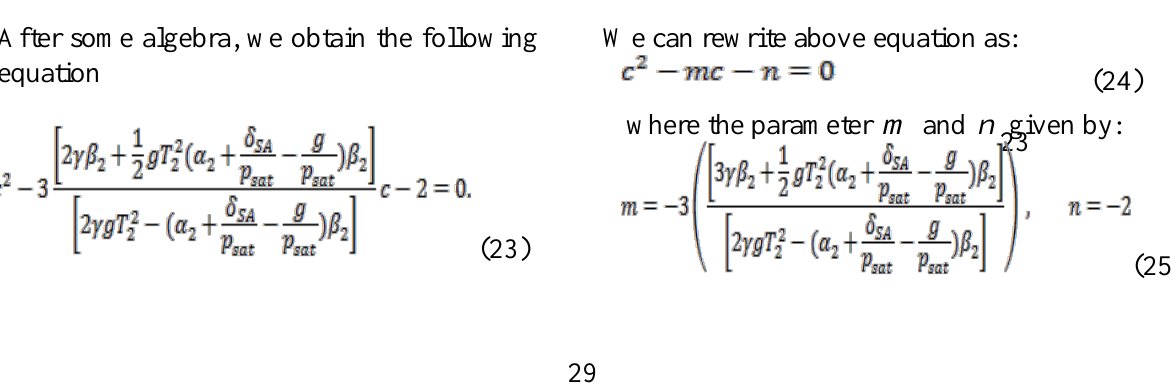
Fig . 1: This schematic shows the fiber laser components such as erbium doped fiber (EDF), single mode fiber (SMF), wavelength division multiplexer (WDM), polarization controller, coupler and optical